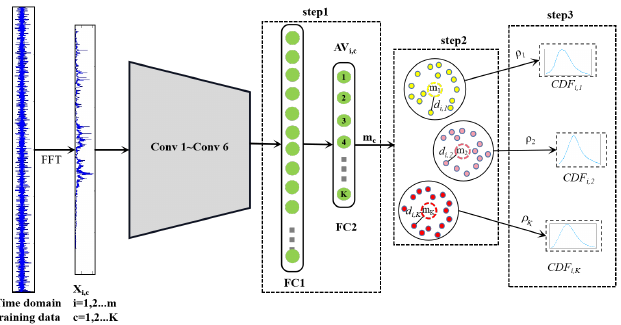
Figure 3. The training phase of the proposed OSA fault diagnosis model is divided into three